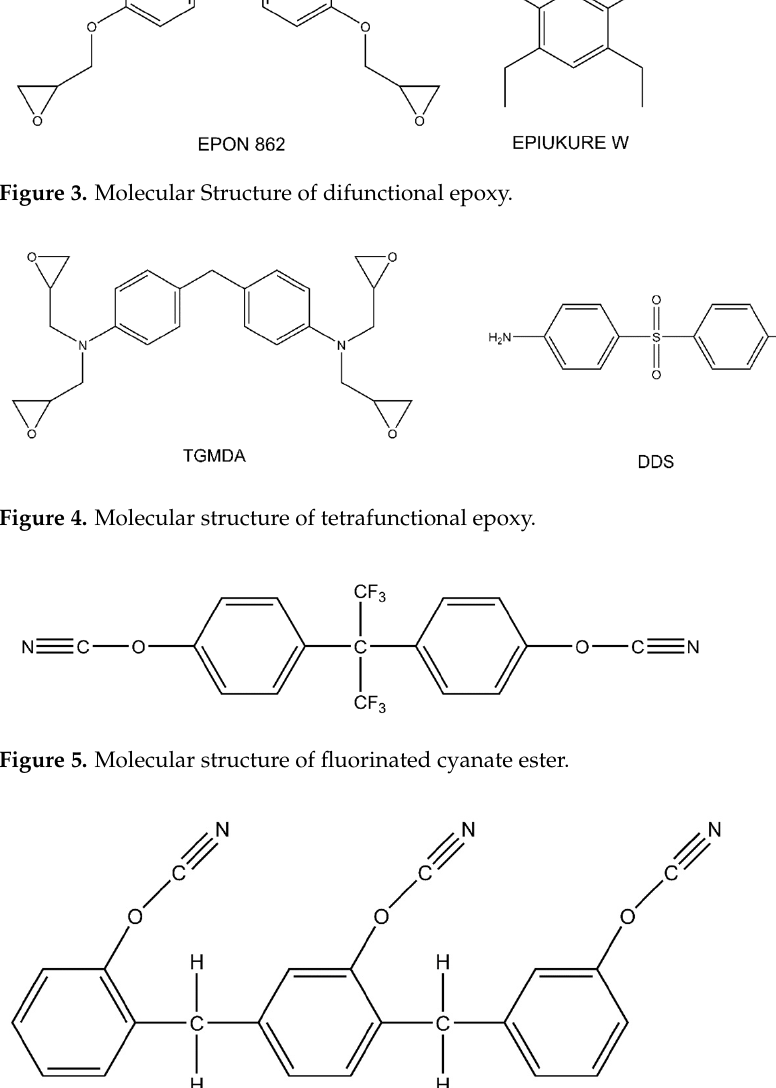
Figure 3. Molecular Structure of difunctional epoxy.